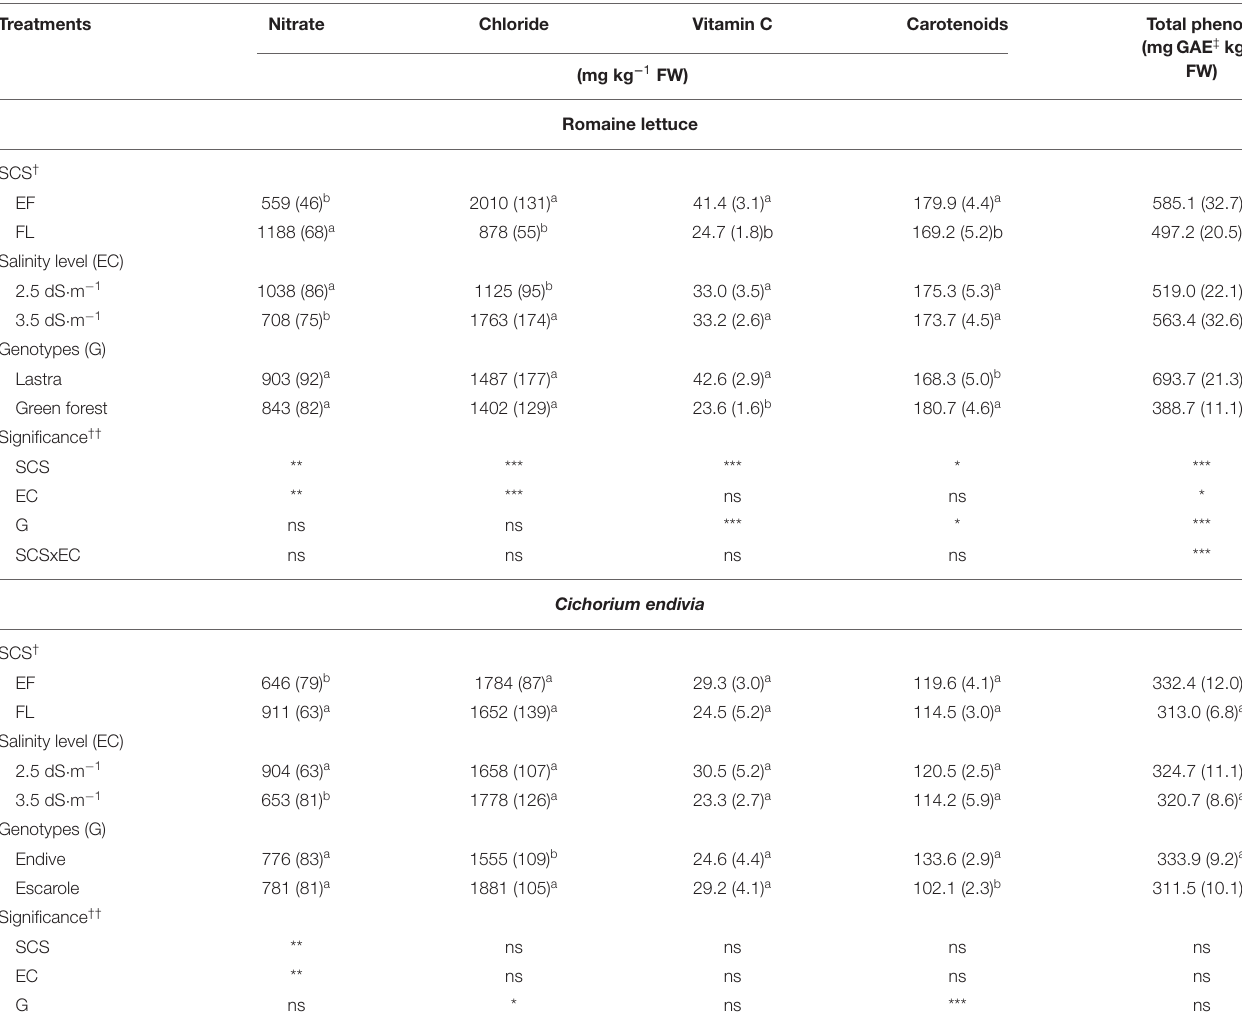
TABLE 4 | Effect of soilless cultivation system (SCS), salinity level (EC) of nutrient solution, and genotype (G) on nitrate, chloride and antioxidant compounds concentration of romaine lettuce (autumn cycle) and C. endivia (winter cycle) leaves.